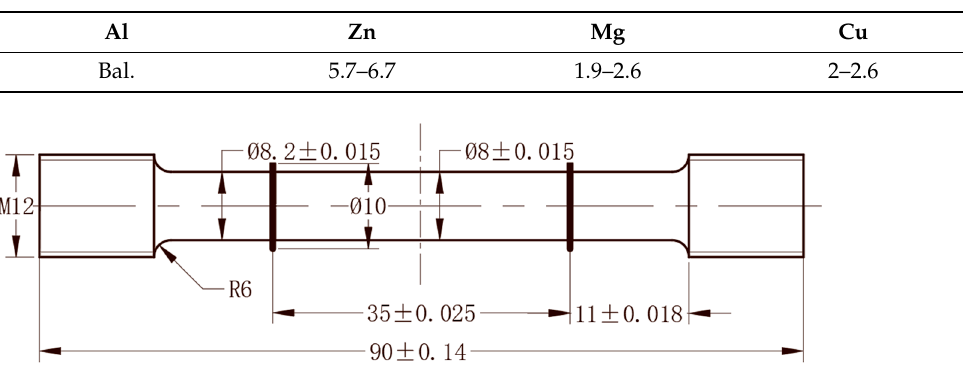
Figure 1. The dimensions of the sample (dimensions in mm).